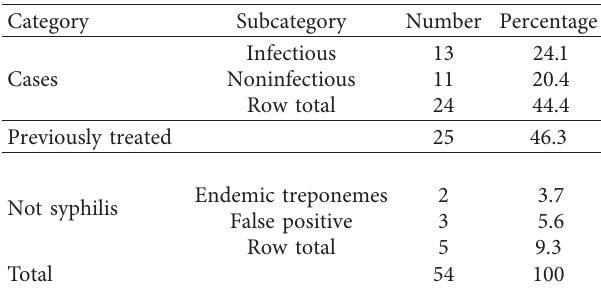
Table 2: Summary of